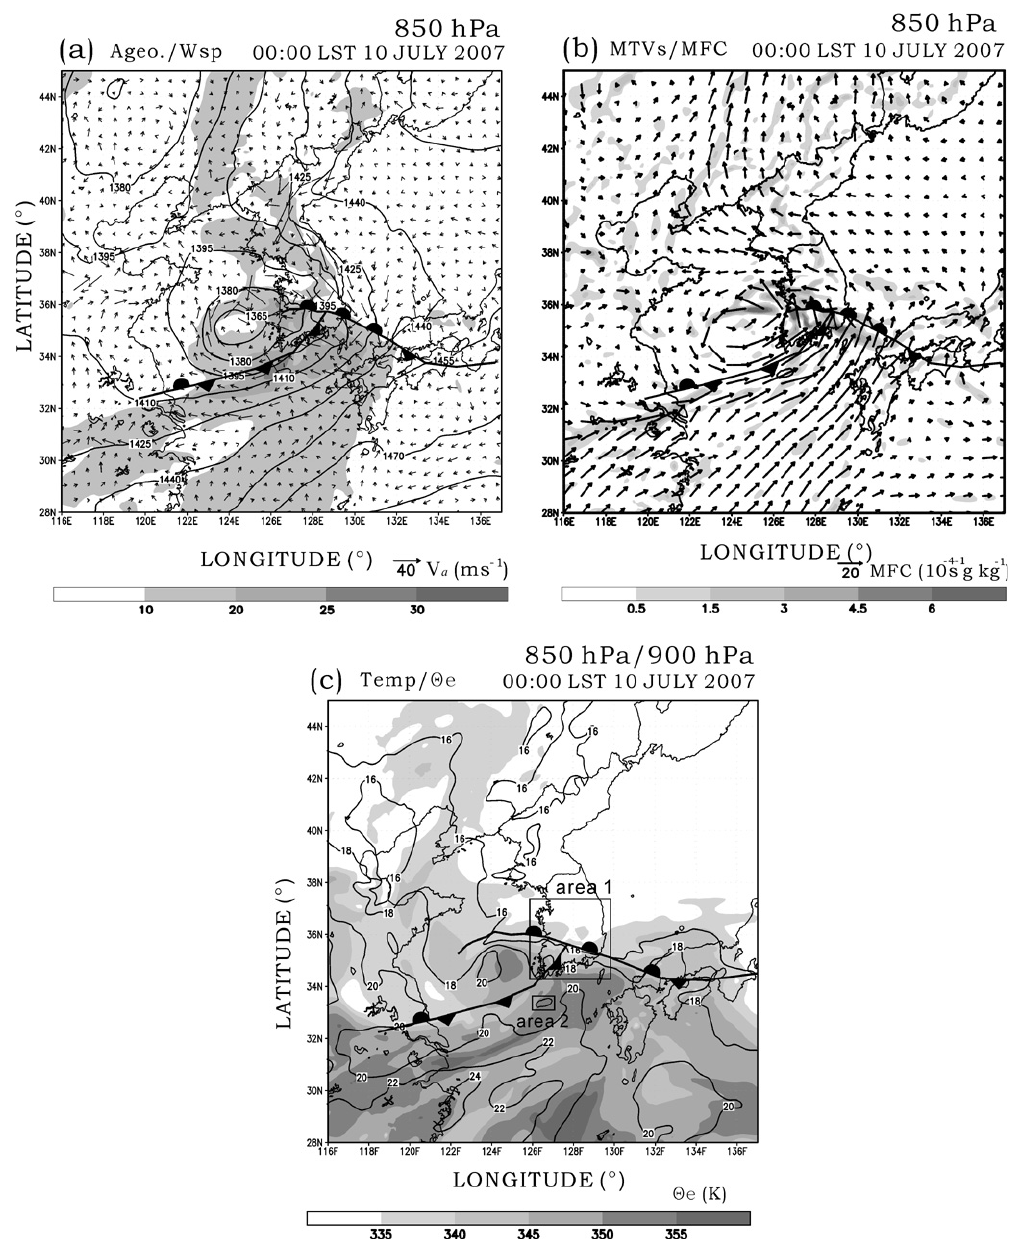
Fig. 7. Mesoscale analysis for 00:00LST, 10 July 2007: (a) geopotential height (contoured every 5gpm), horizontal wind speed (ms − 1 , shaded) and ageostrophic winds (ms − 1 , arrows); (b) moisture transport vectors (ms − 1 gkg − 1 , arrows), moisture flux convergence (10 − 4 s − 1 gkg − 1 , shaded) at 850hPa; and (c) equivalent potential temperature θ e (K, shaded) at 900hPa, and temperature (contoured every 2 ◦ C) at